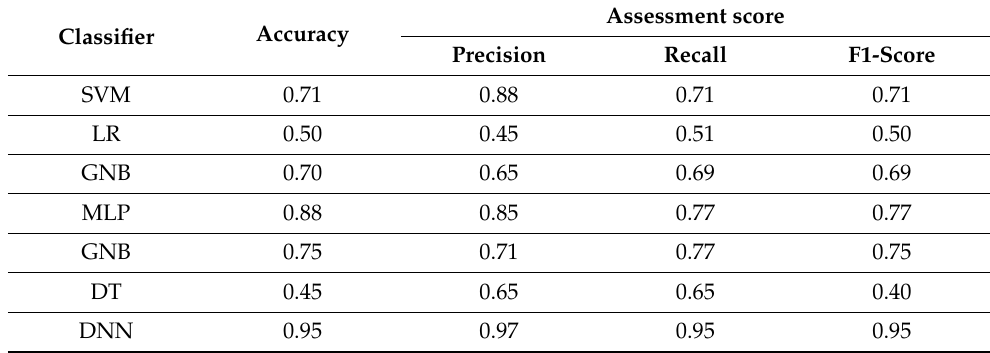
Table 3. The confusion matrix and the controlled learning models for the retrieved documents.